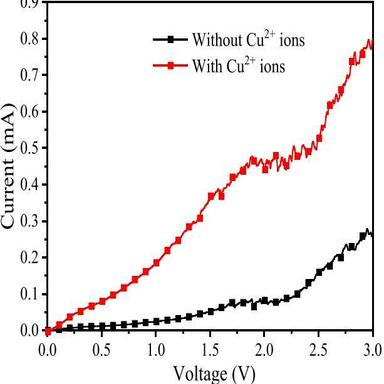
Current-Voltage (I-V) responses for the ZIF-8/SPE in the absence and presence of Cu2+ ions.